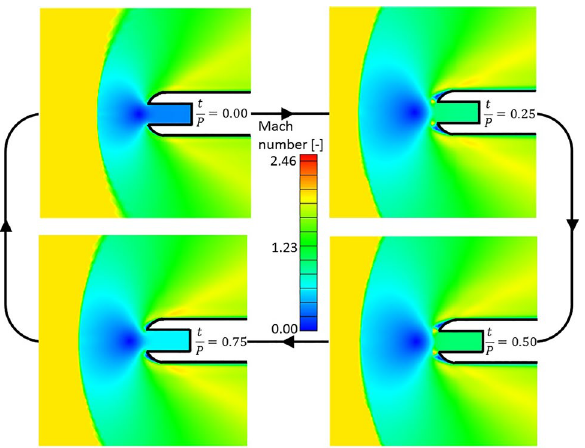
Figure 20. Time snapshots of the Mach number contour at the leading edge region throughout a fluctuation period for T 0 cooling / T 01 = 0.5 , f = 10Hz .